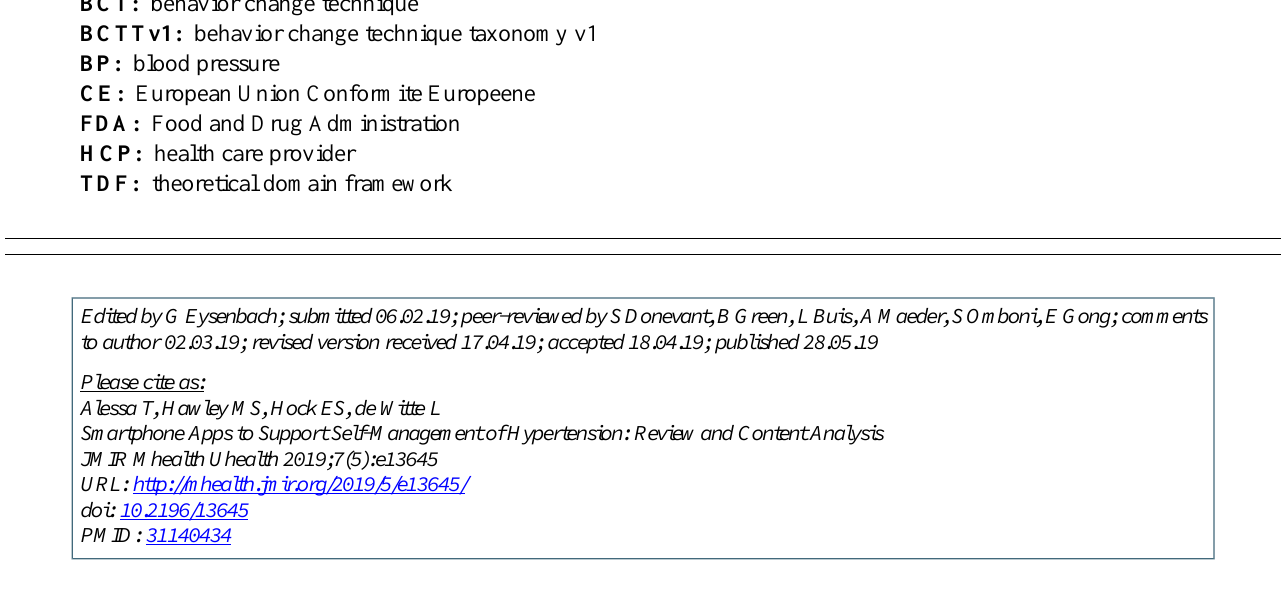
BCT: behavior change technique BCTTv1: behavior change technique taxonomy v1 BP: blood pressure